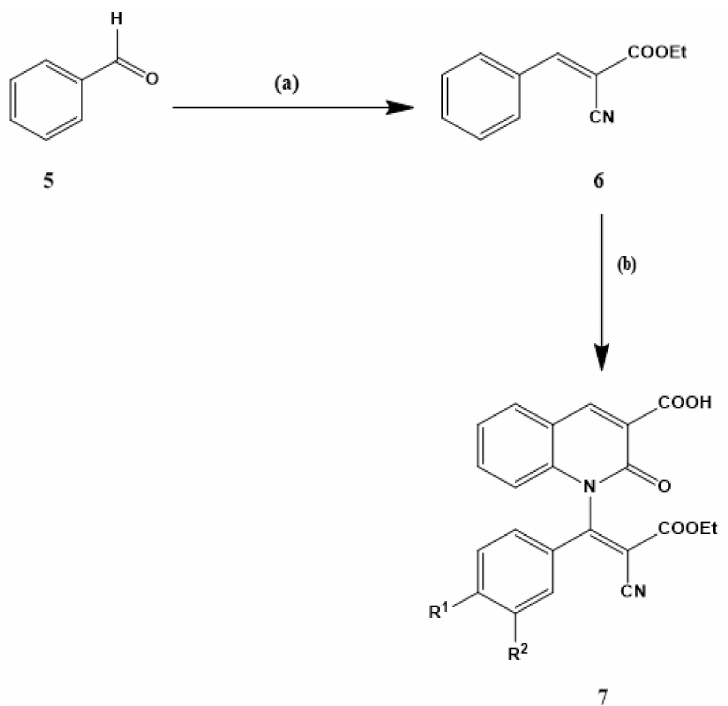
Scheme 2. Synthesis of 1-[2-cyano-2-ethoxycarbonyl-1-arylvinyl]-2-oxo-1, 2-dihydroquinoline-3- carboxylic acid derivatives ( 7a – d ). Reagents and conditions: (a) ethyl cyanoacetate, Et 3 N, EtOH reflux; (b) 2-oxo-1,2-dihydroquinoline-3-carboxylic acid, Et 3 N DMF/reflux. ( 7a , R 1 = R 2 = H; 7b ,